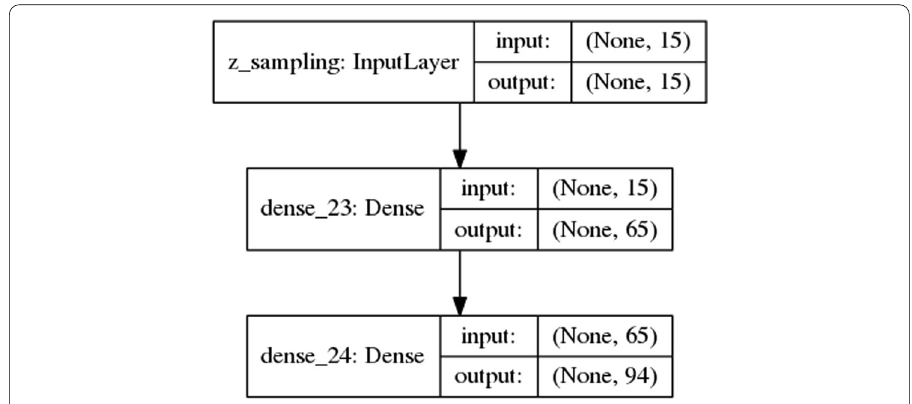
Fig. 6 Decoder component of the VAE